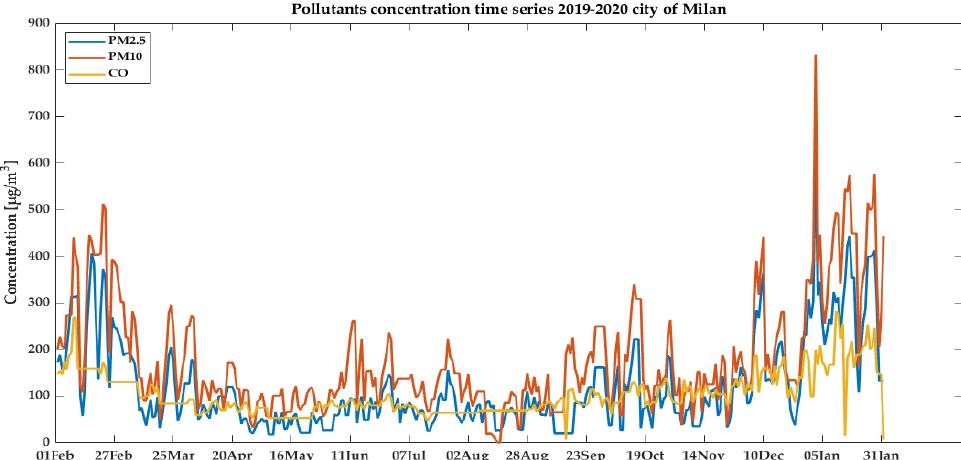
Figure 3. Example of extracted time-series of three pollutants (PM 2.5 , PM 10 , and CO) in the city of Milan for the considered retrospective period of 12 months, from 1 February 2019 to 31 January